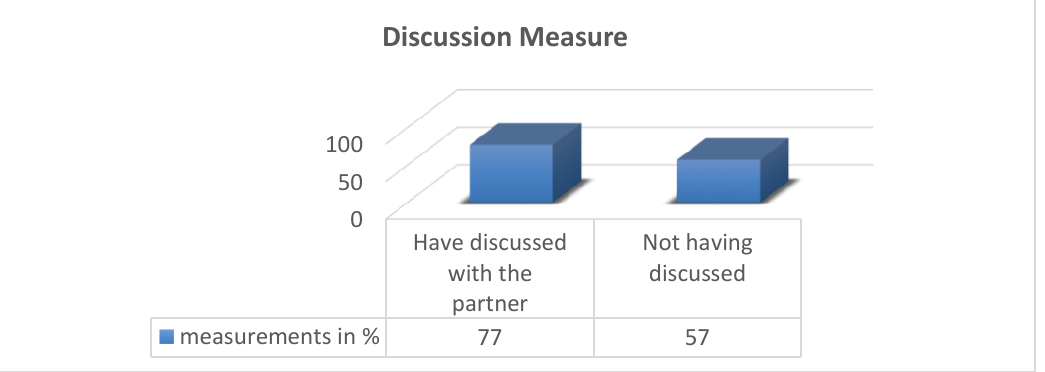
Figure 2: Use of modern contraceptive methods according to whether the woman discussed family planning with her